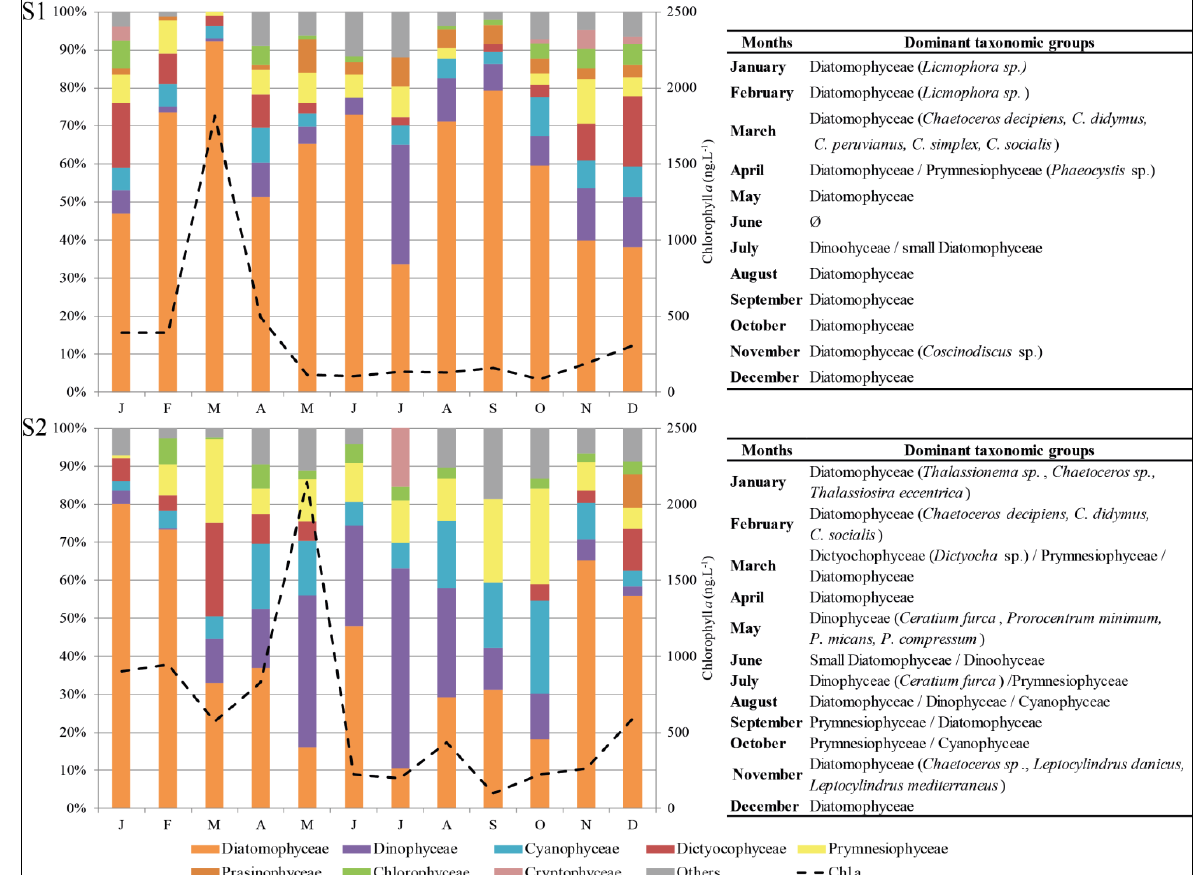
Figure 3. Spatio-temporal subsurface diversity of phytoplankton assemblages and Chl a variation, during 2010, at S1 and S2 stations (Ø no dominant taxonomic